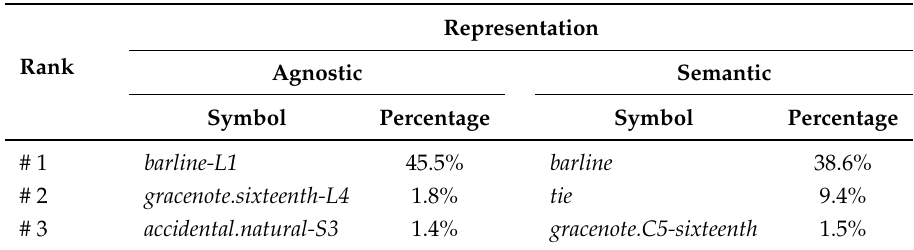
Table 5. List of the 3 most common errors with respect to the representation considered. Percentages are relative to the total error rates from Table